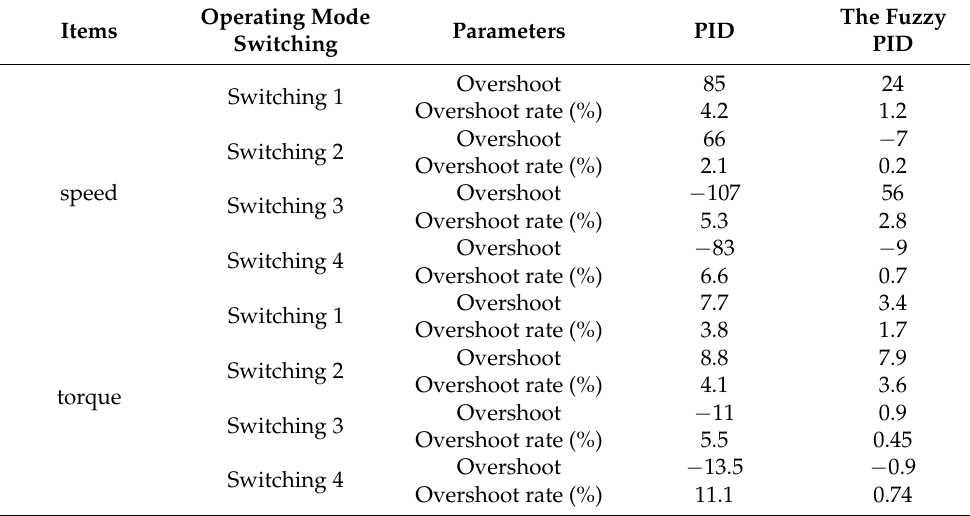
Table 5. Speed and torque overshoot during switching between the traditional PID and fuzzy PID working